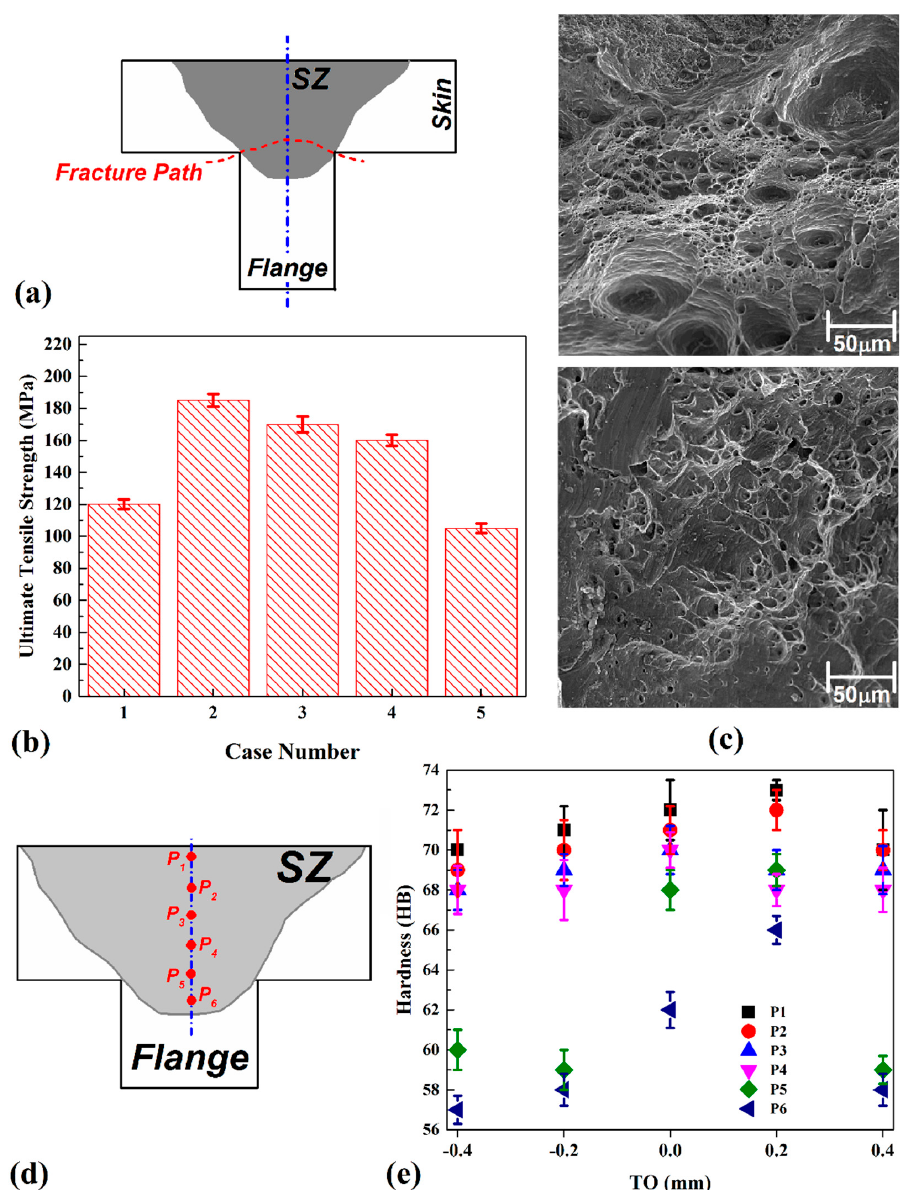
Figure 8. ( a ) Schematic view of fracture path during tensile test. ( b ) Tensile strength of joints. ( c ) SEM image of the fracture surface in case 2. ( d ) Schematic view of selected points for hardness test. ( e ) Hardness test results.